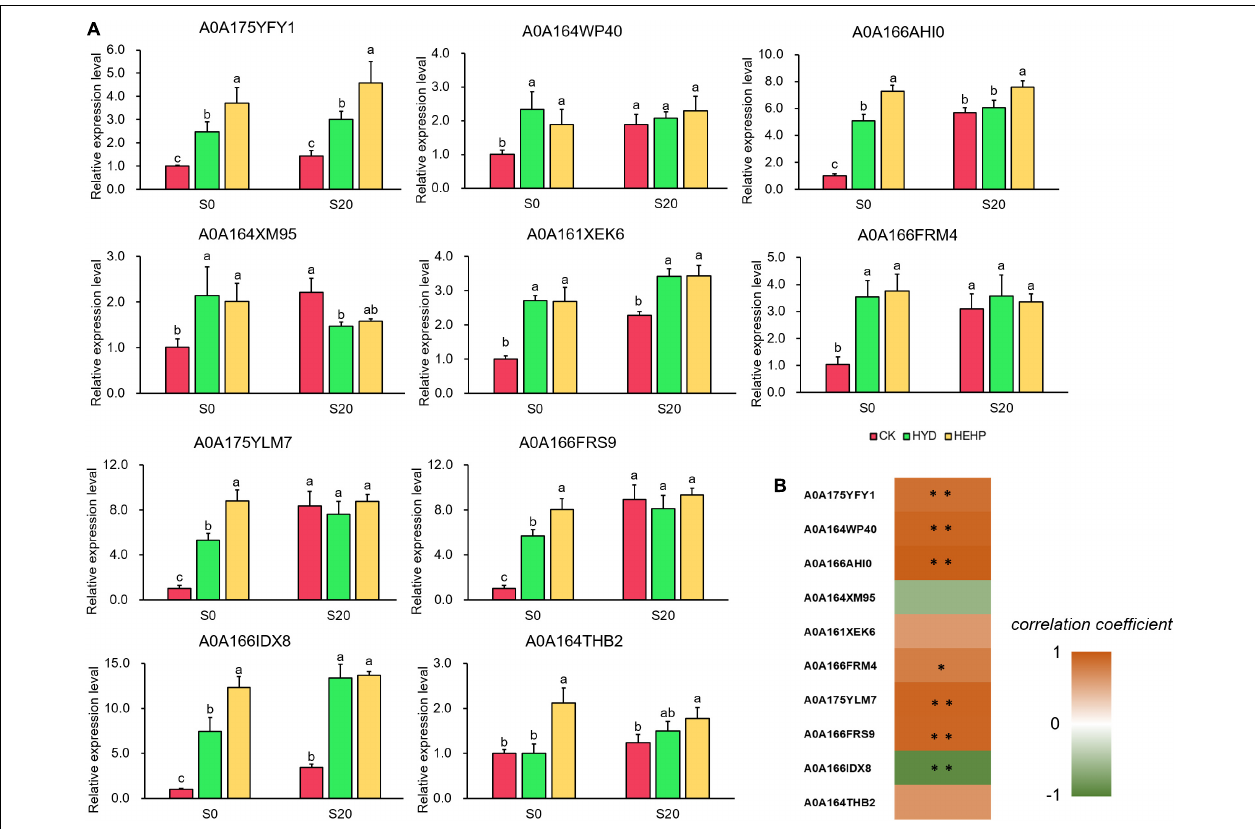
FIGURE 8 | Real-time quantitative PCR (qRT-PCR) analysis of 10 selected DAPs at S0 and S20. (A) Expression patterns at the transcriptional level of 10 selected DAPs from qRT-PCR; (B) correlation analysis between the results of qRT-PCR and the proteome. Spearman correlation coefficient was used. ∗ Means significant at the level of p < 0.05. ∗∗ Means significant at the level of p < 0.01. The different lowercase letters above the bars indicate significant differences in 95% probability level ( p < 0.05, Duncan test was per-formed after ANOVA